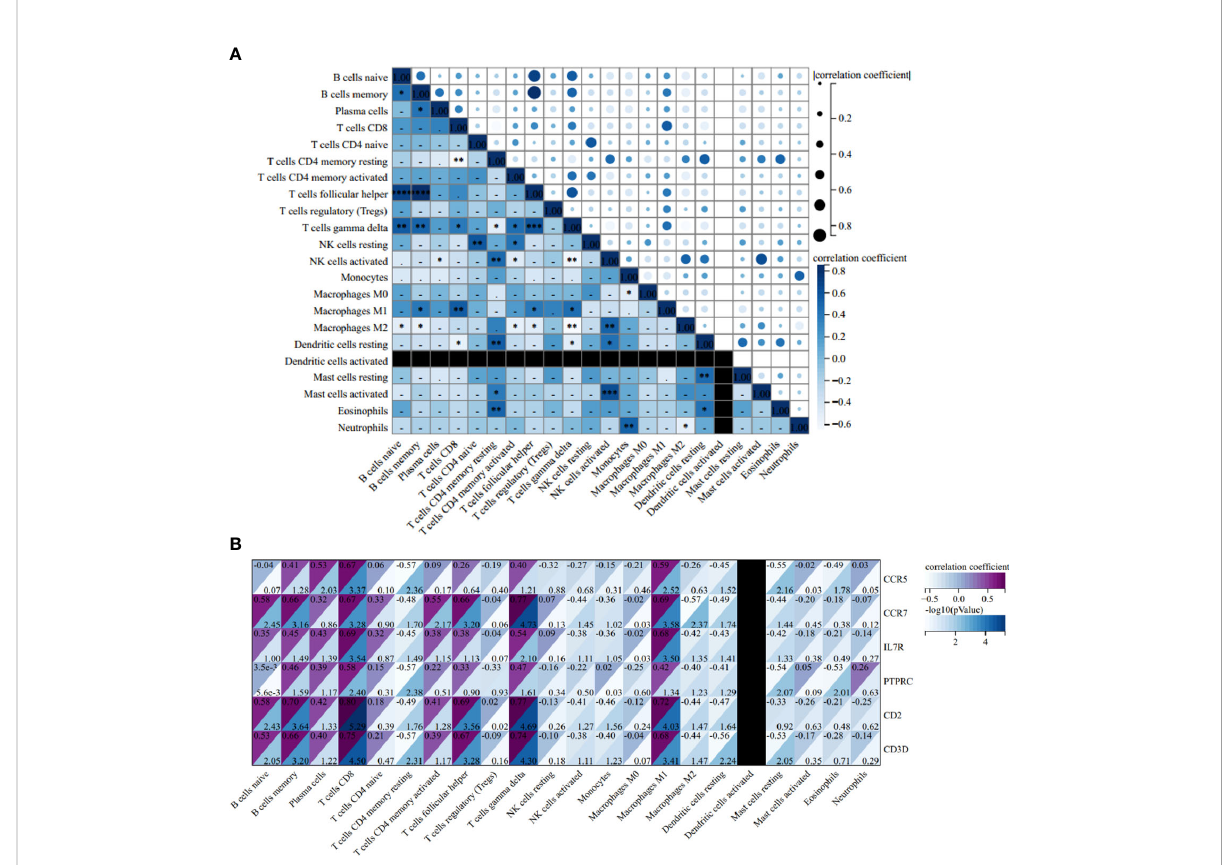
FIGURE 13 Correlation Analysis in RA. (A) Related heat maps of 22 immune cells in GSE55457. (B) Correlation heat map between hub genes and immune cells in GSE55457. *p < 0.05; **p < 0.01; ***p <